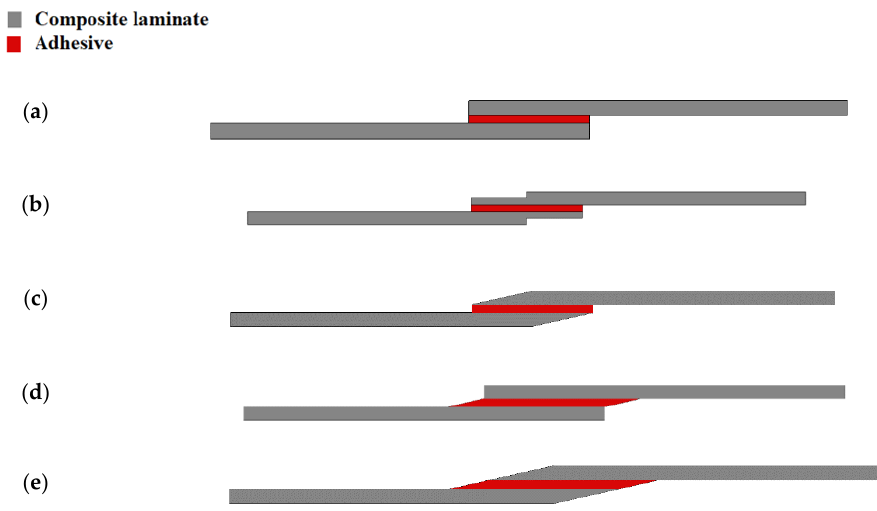
Figure 16. Schematic design for ( a ) single lap joint, ( b ) adherend recessing, ( c ) adherend chamfering, ( d ) adhesive chamfering and ( e ) adherend and adhesive chamfering. Adapted from [136].